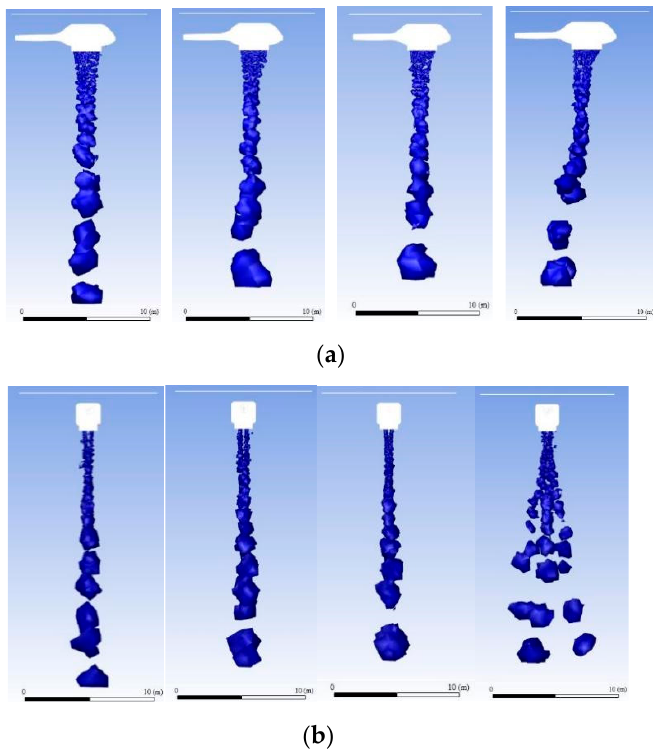
Figure 25. Contour surface of the two-phase, water–air interface at a volume fraction of 0.01 under different wind speeds ( H = 20 m; the ground is at the ruler in the figure; t = 1.8 s). ( a ) Side view, displaying U = 0 m/s, 5 m/s, 10 m/s, and 15 m/s, respectively, from left to right. ( b ) Front view, showing U = 0 m/s , 5 m/s, 10 m/s, and 15 m/s, respectively, from left to right.